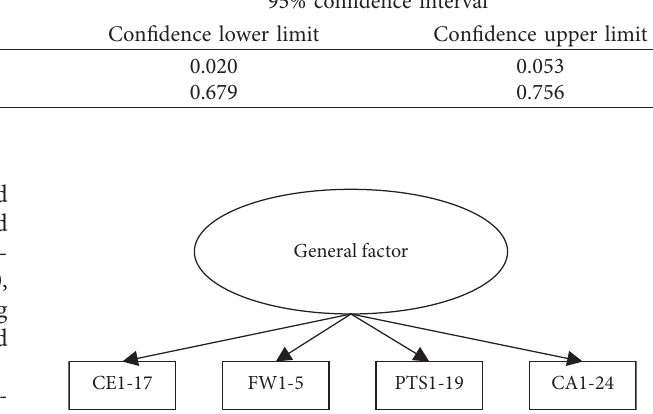
Figure 2: Harman’s single-factor test. CE1-17: career exploration1- career exploration17. FWS1-5: future work self-salience1-future